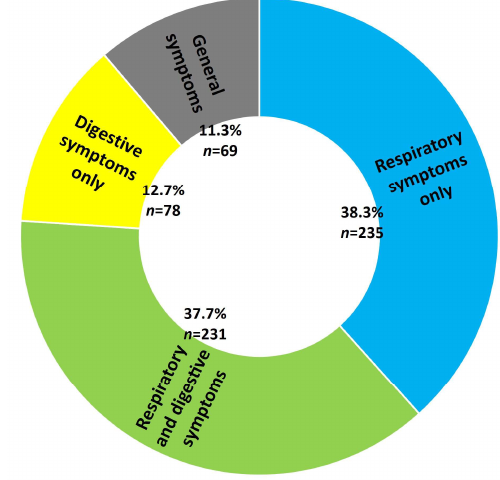
Figure 1. Distribution of symptom type in infants in the study. White blood cell (WBC) counts showed no significant patterns, with a median of 6800 cells/μL (IQR: 4900, 9500 cells/μL); 24.6% (n = 151) showed increased WBC and 7.3% (n = 45) decreased WBC. A high number of infants, 82.9% (n = 508), had anemia at the time of hospitalization with median hemoglobin values of 10.9 g/dL (IQR: 10.2, 11.7 g/dL). Aspar- tate aminotransferase (AST) and lactate dehydrogenase (LDH) values were elevated in 80.1% (n = 491) and 83.8% (n = 514) of cases, respectively. In contrast, alanine aminotrans- ferase (ALT) was abnormally high in 32.1% (n = 191) of patients. Increases in interleukin- 6 (IL-6) were identified in 96.7% (n = 88/91) of infants, with a median of 177.7 pg/mL (IQR: 57.5, 1333.5 pg/mL) (Table 2). Table 2. Laboratory findings in infants included in the study. Laboratory Analysis